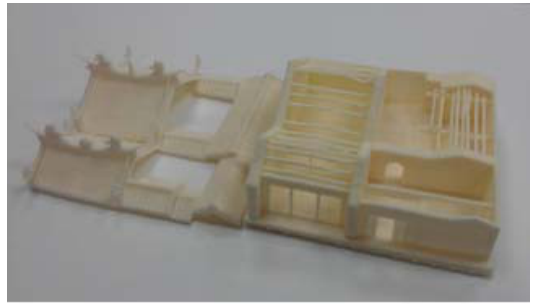
Figure 18. Interior of Taipei Xia Hai City God